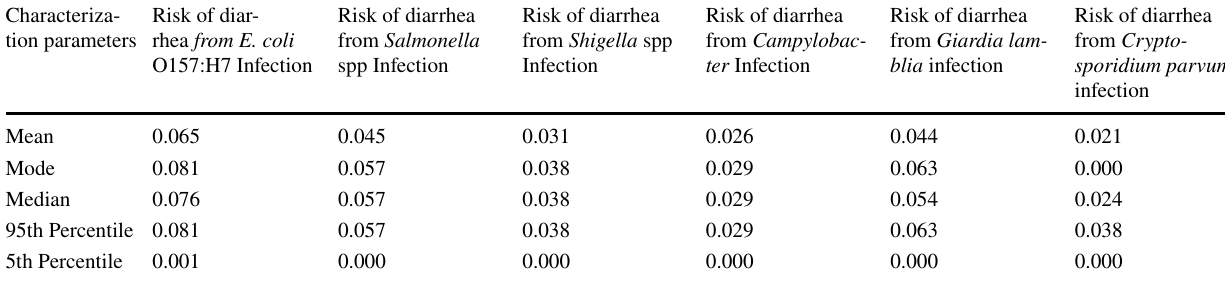
Table 12 Risk of diarrhea disease characterization Characteriza- Risk of diar- tion parameters rhea from E.